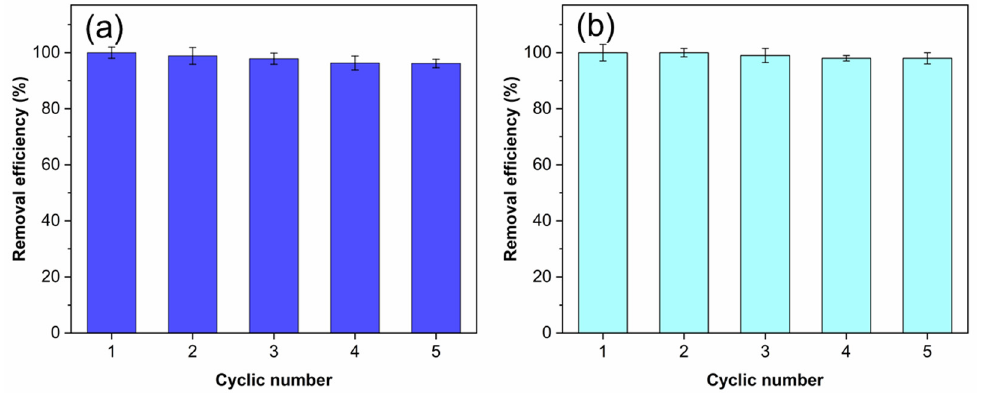
Figure 8. The removal efficiency of HGC-2 beads in sorption of ( a ) MB and ( b ) Cu (II) ions for five cycles. Experimental cycles. Experimental conditions: 50 mg of MB or 500 mg of Cu(II) ions, 100 mg of dried HGC-2 conditions: 50 mg of MB or 500 mg of Cu(II) ions, 100 mg of dried HGC-2 beads, 100 mL solution, pH 8.0 (MB), or pH 5.0 (Cu(II) ions) under room temperature.